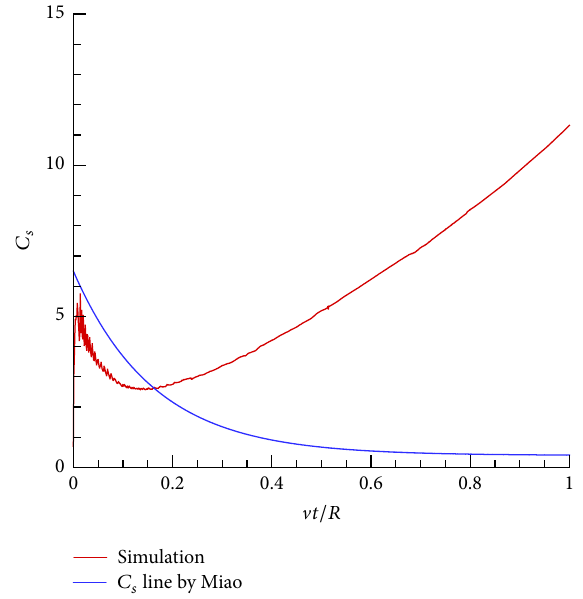
Figure 8: Vertical hydrodynamic force on a circular cylinder.